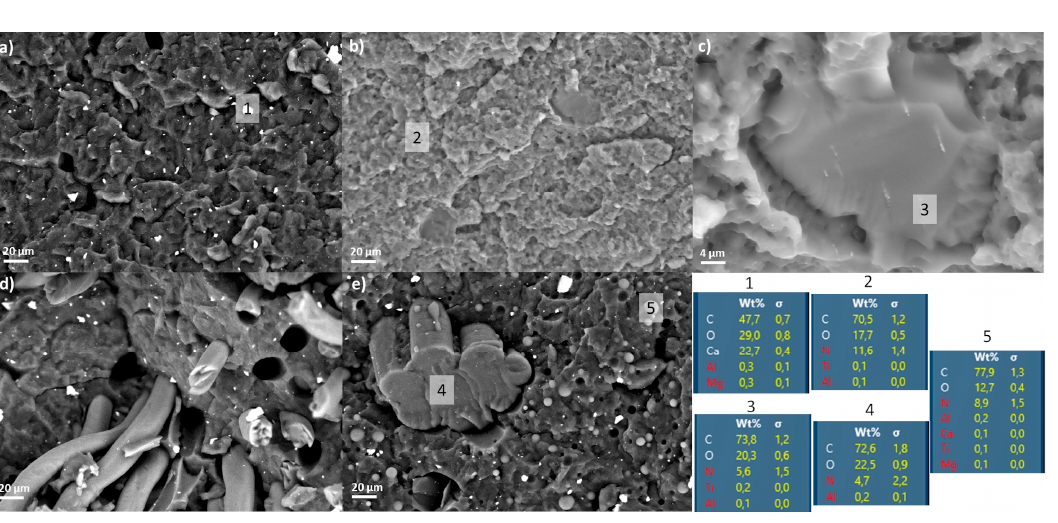
Figure 8. SEM images of: ( a ) FM_EX190, ( b , c ) EL_EX230, ( d ) FM_EL_EX190, and ( e ) FM_EL_EX230.